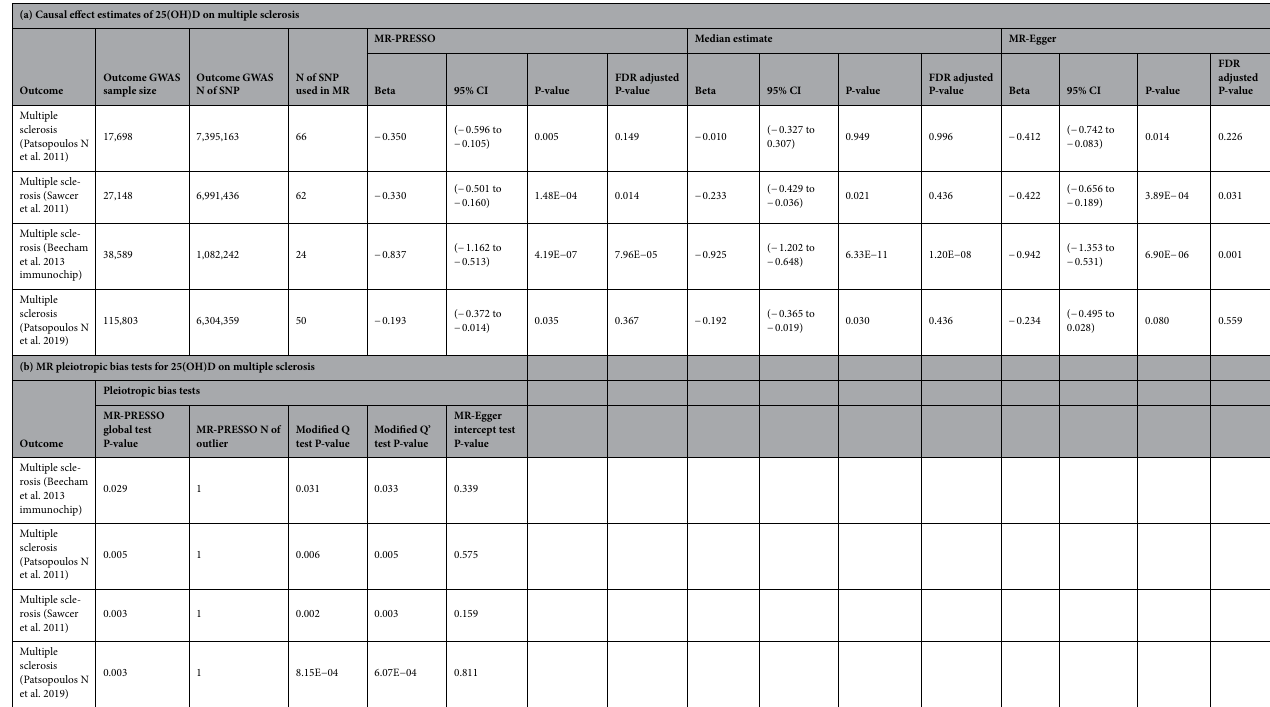
Table 1. Causal effect estimates of 25(OH)D and MR pleiotropic bias tests for multiple sclerosis using 138 conditionally independent SNPs in vitamin D associated loci from Manousaki, D. et al. AJHG